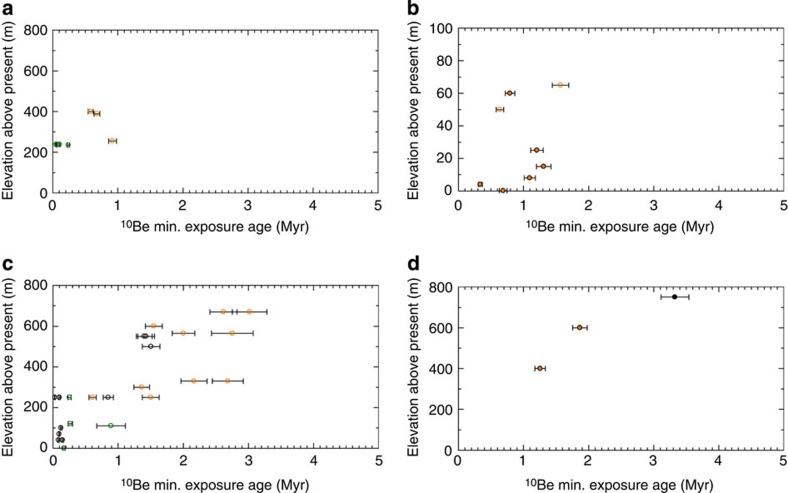
Area 2 ice sheet history.Compiled exposure ages from (a) Ricker Hills31, (b) Allan Hills2532, (c) Dry Valleys333435 and (d) Shackleton Range36. In each panel, 1σ uncertainty is shown; orange and green symbols indicate simple and complex exposure histories, respectively; black symbols indicate samples lacking 26Al measurement; and filled and open symbols refer to bedrock and erratic samples, respectively.